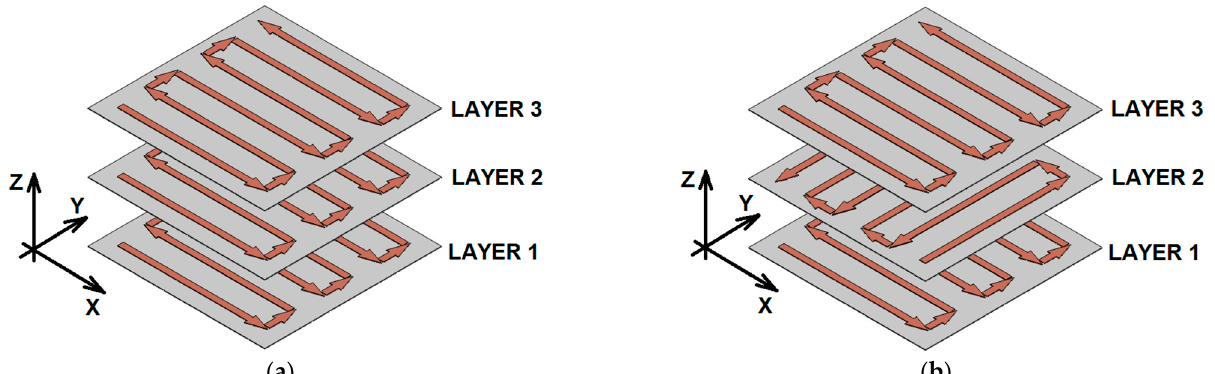
Figure 5. Different robot path strategies for CS-ed deposition. ( a ) Traditional or bidirectional, and ( b ) cross-hatching.